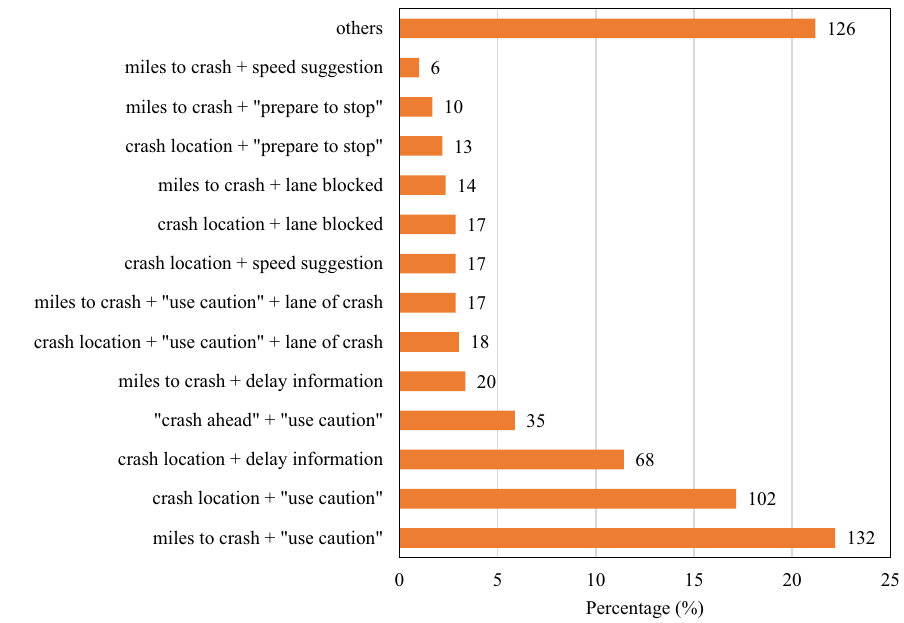
Figure 3 Proportion of VMS messages by different content